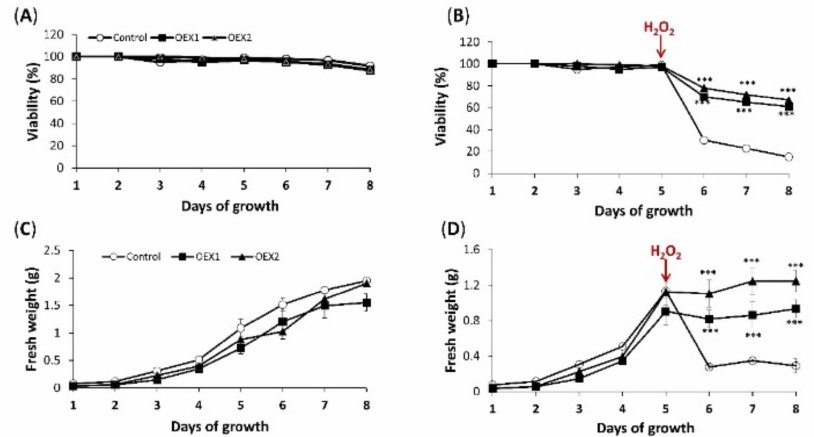
Figure 1. Cell viability and fresh weight of control and two lines of overexpressing PsTRX o 1 (OEX1 and OEX2) TBY-2 lines ( A , C ) and after 35 mM H 2 O 2 treatment ( B , D ). Cell viability (percentage) was measured using Trypan Blue dye during the 8 days of culture. H 2 O 2 was added at day 5 of growth as indicated by the arrows. Values represent mean ± standard error of four independent experiments. Differences of OEX cells values related to the control line in each time point in ( A , C ) were not significant according to Student’s t -test ( p < 0.05, n > 1000 cells) while *** represent significant differences in ( B , D ) ( p < 0.001, n > 1000